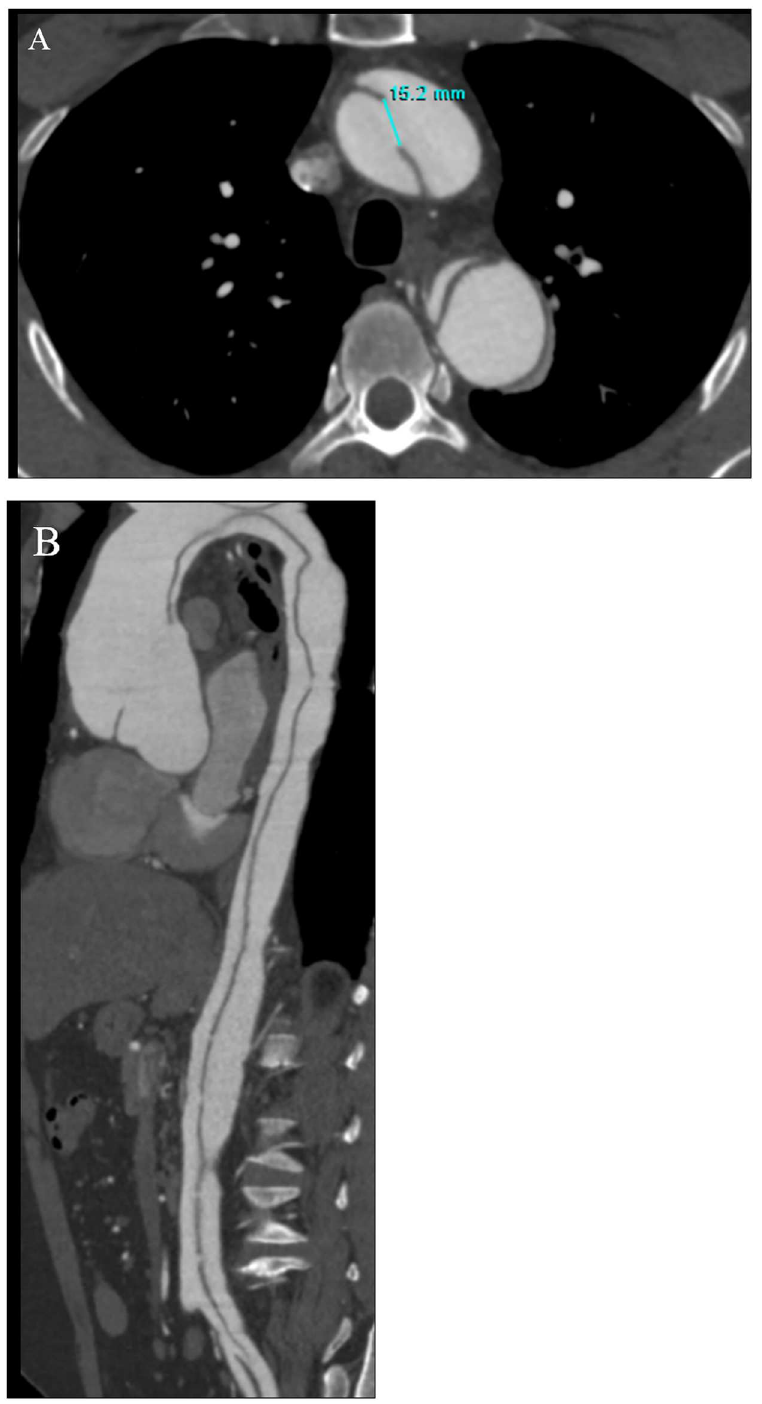
Fig 4. Example of size measurement and numbers of the entry tears. (A) Primary entry tear locatedin the aortic arch. (B) MPR image displayingfive small re-entry tears in descending and abdominal aorta, with the primary entry tear locate in the